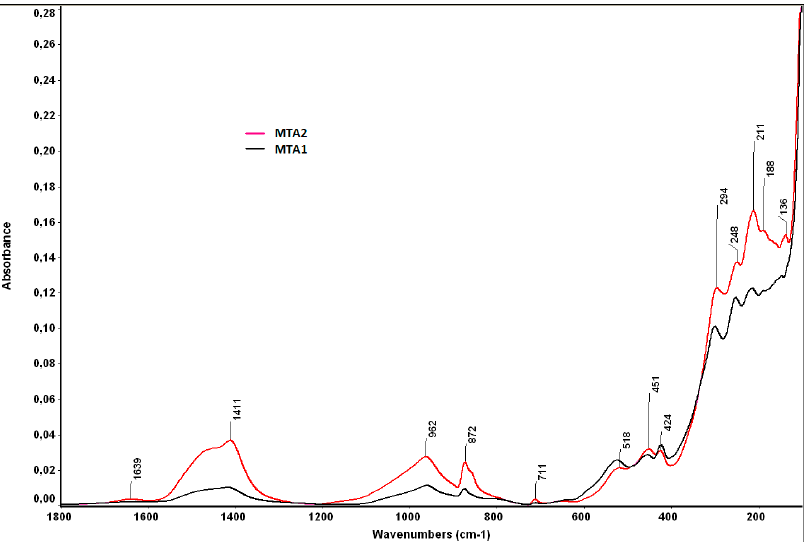
Figure 11. FT-IR spectra of MTA pastes hydrated for 7 days and the immersed SBF for 14 days.